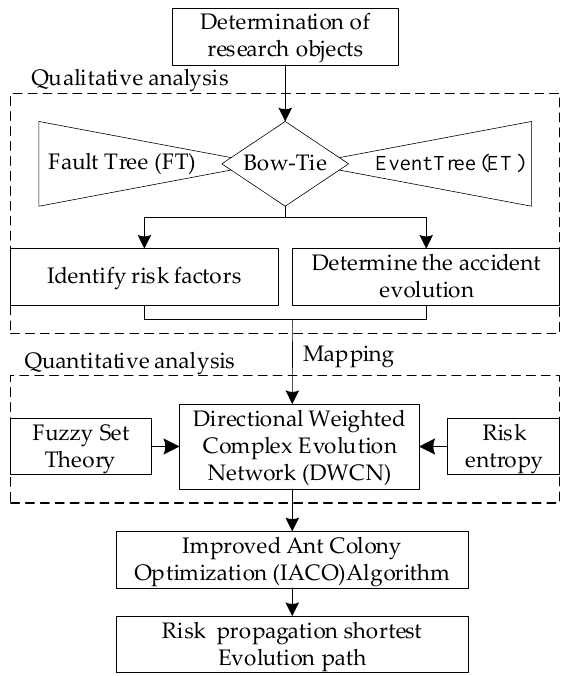
Figure 1. The proposed methodology for assessing the accident shortest path.